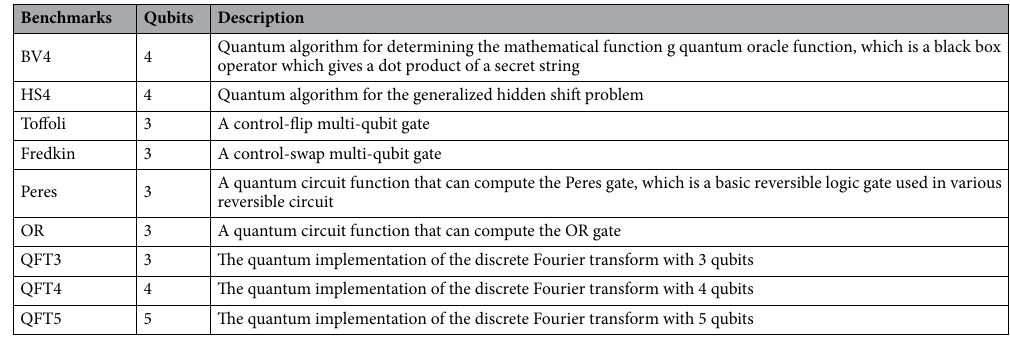
Table 1. Benchmarks used in this paper.